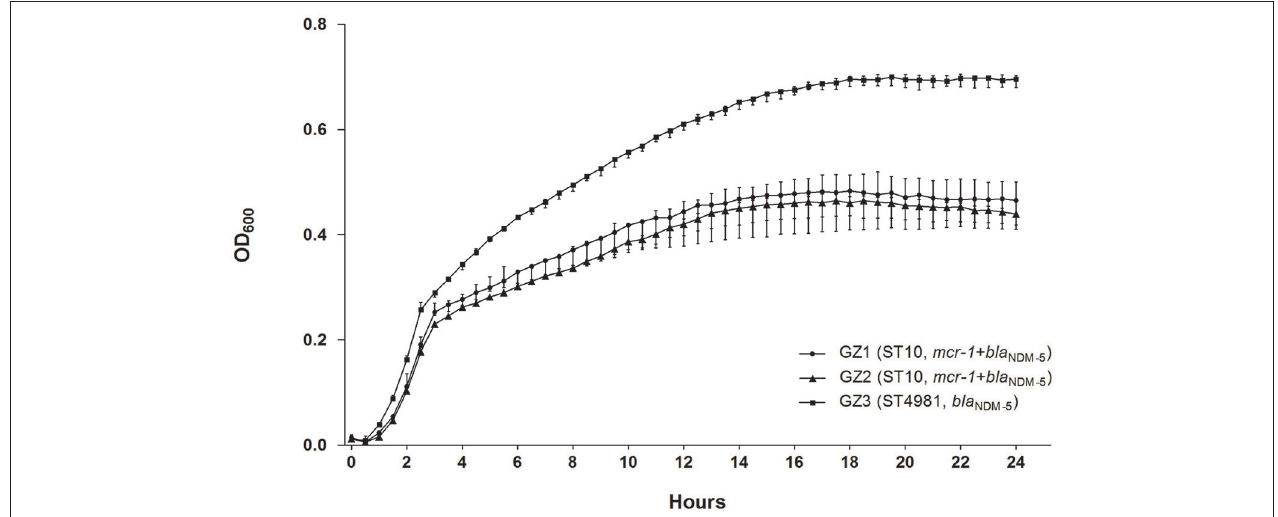
FIGURE 1 | In vitro growth of GZ1, GZ2, and GZ3 cultured at 37 ◦ C in LB broth. The growth of GZ3 was significantly higher than the other two strains ( P < 0.001). Data points represent the mean ( ± standard deviations) of three independent experiments.